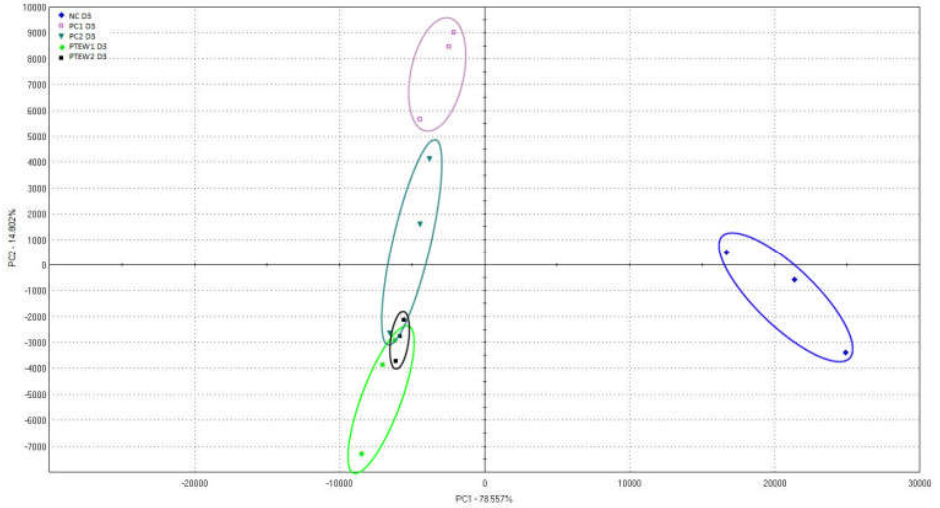
Figure 4. Principal component analysis of liver pâtés—day 3; NC—negative control (liver pâtés without a nitrite source); PC1—positive control (liver pâtés with 60 ppm of sodium nitrite); PTEW1—liver pâtés with plasma-treated egg white containing 40 ppm NO 2− ; PC2—positive control (liver pâtés with 120 ppm of sodium nitrite); PTEW2—liver pâtés with plasma-treated egg white containing 80 ppm NO 2− .